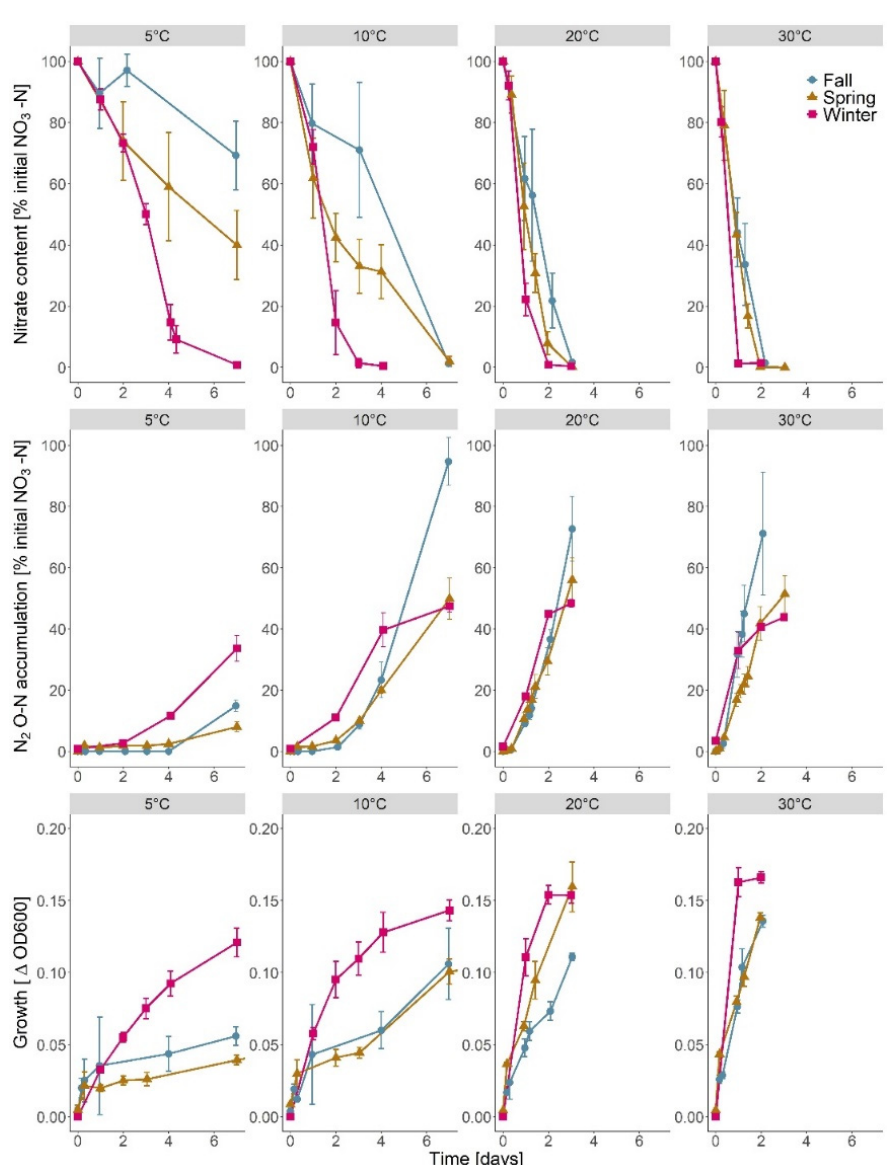
Figure 1. Time course of nitrate (NO 3 − ) depletion (first row), denitrification (second row), and growth (third row) of NO 3 − reducing enrichments from a woodchip bioreactor sampled in spring fall, and winter. Enrichments were assayed at 5, 10, 20, and 30 °C. Denitrification was assayed as N 2 O production in cultures amended with acetylene, and growth was measured as the increase in optical density at 600 nm ( ∆ OD 600 ).